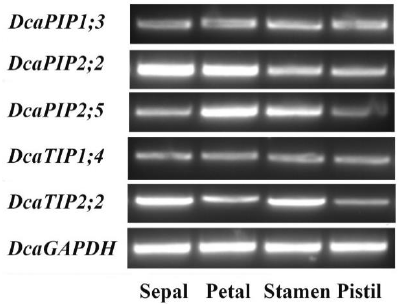
Figure 6. Expression profile of DcaAQP genes in different flower organs. Expression profile was examined by semi-qRT-PCR. DcaGAPDH was used as standard control to normalized the data.